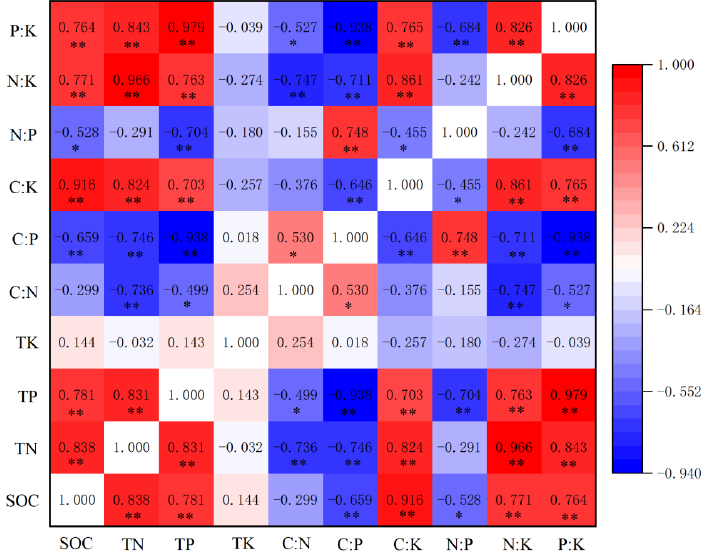
Figure 8. Pearson’s correlation heatmap of bulk soil C, N, P, K concentrations and stoichiometric